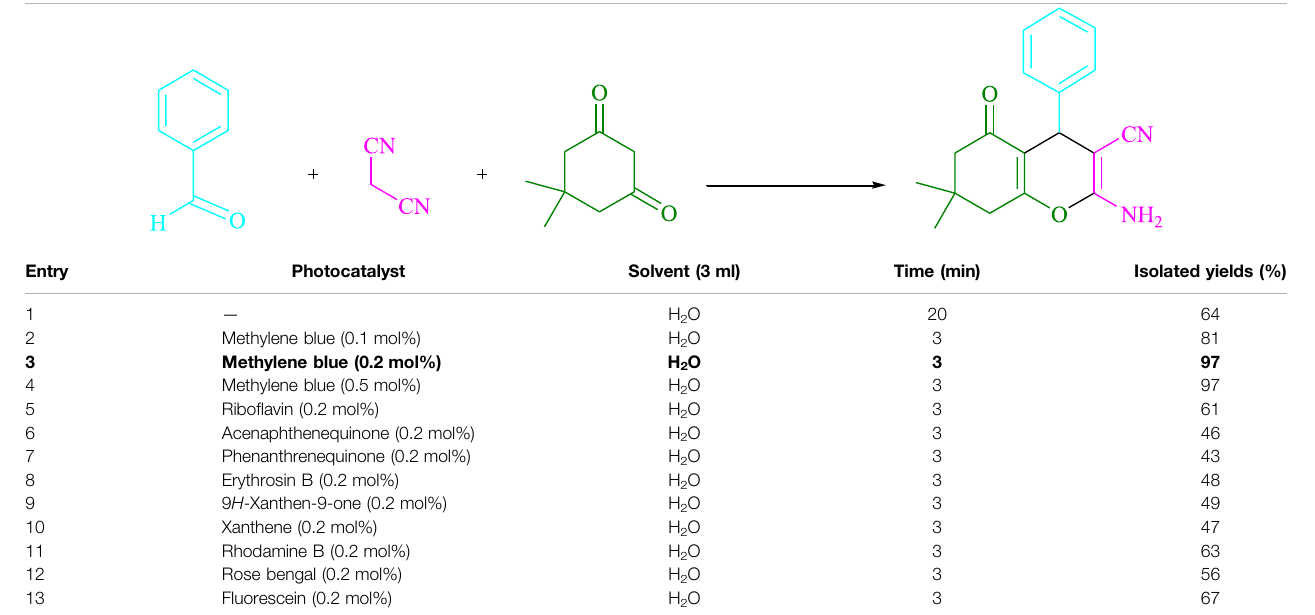
TABLE 1 | Optimization of various photocatalysts a .